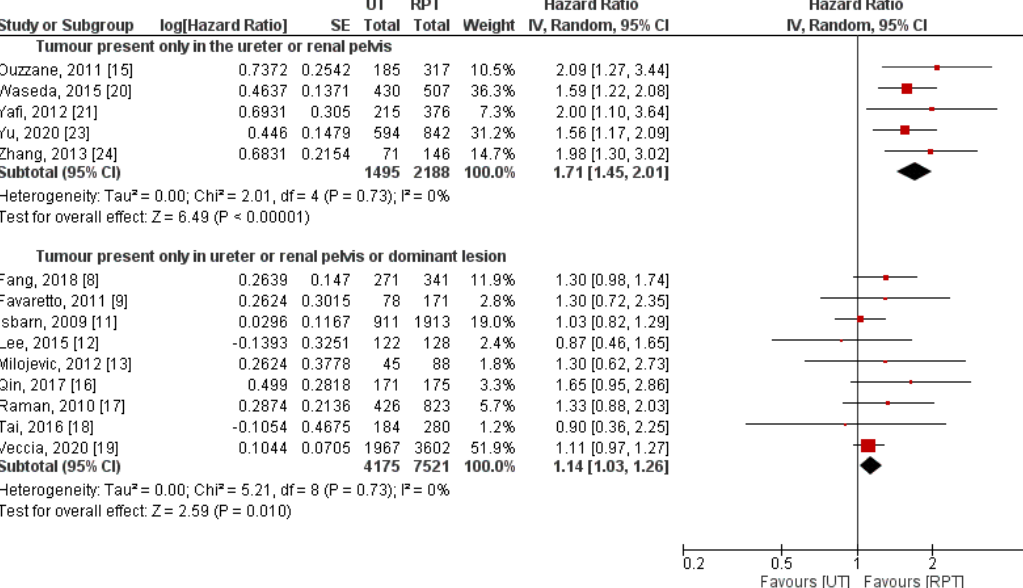
Figure 7. Forest plot and subgroup analysis of cancer-specific survival stratified by definition of primary UTUC location [8,9,11–13,15–21,23,24]. CI = confidence interval; IV = inverse variance; RPT = renal pelvic tumor; SE = standard error; UT = ureteral tumor.